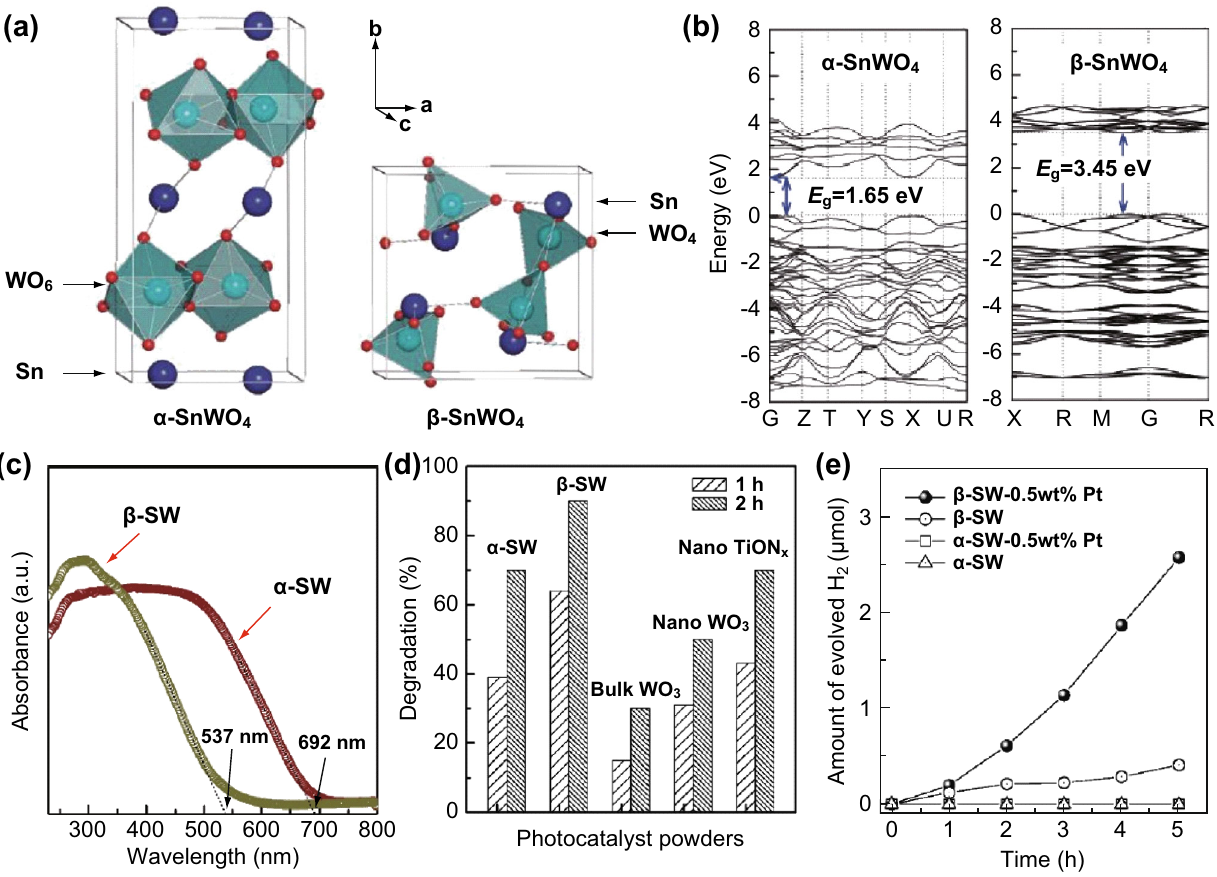
Fig. 6 a Crystal structures, b density of states, and c UV–Vis absorption spectra of a -SnWO 4 and b -SnWO 4 . d Photocatalytic activity of a - SnWO 4 and b -SnWO 4 in RhB degradation. e H 2 evolution. Reproduced with permission from Ref. [88]. Copyright 2009 American Chemical